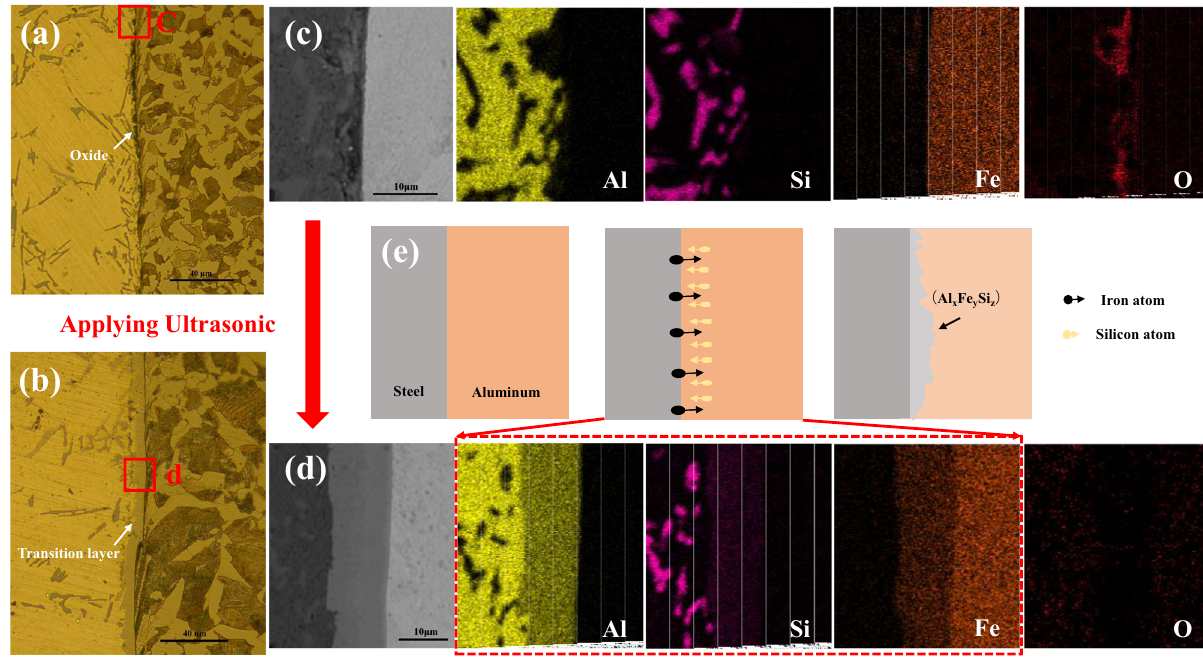
Figure 4: Detailed structure and phase of the bimetallic castings. OM images, SEM micrographs, and EDS analysis of interface micro - structure ( a ) and ( c ) without ultrasonic treatment; ( b ) and ( d ) ultrasonic treatment. Diagram ( e ) showing element di ff usion in the formation of intermetallic compounds.